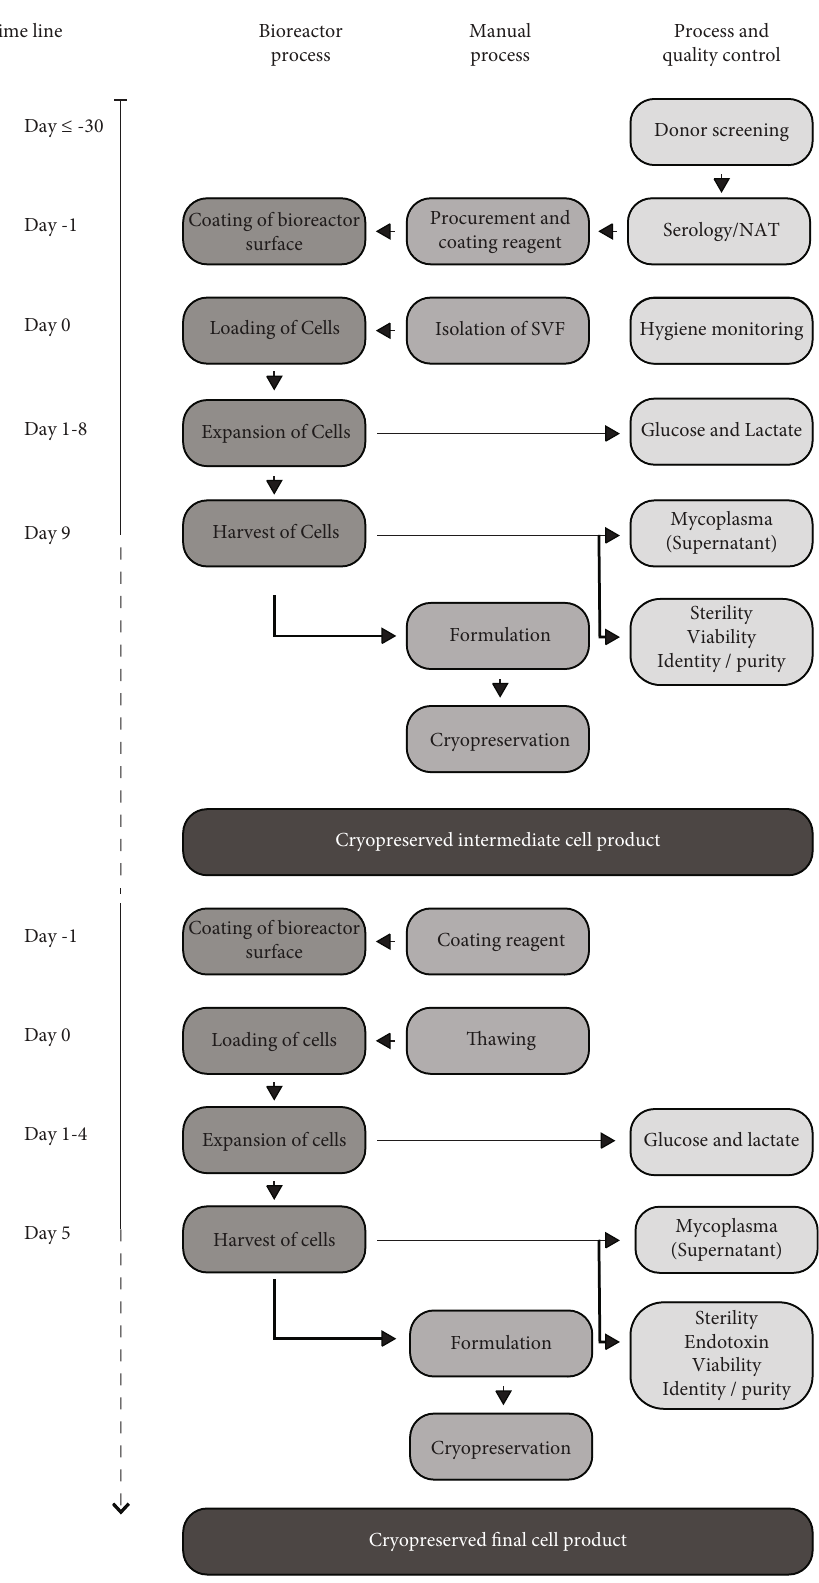
Figure 1: The manufacturing process overview. Timeline for di ff erent steps during manufacturing of intermediate and fi nal cell